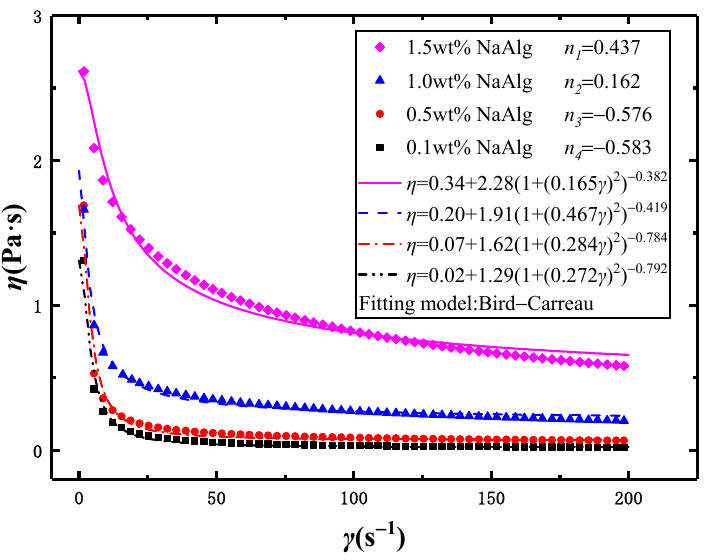
Figure 2. The relationship between the viscosity ( η ) and the shear rate ( γ ) with four mass fractions of the NaAlg solution (The solid line displays the fitting result of the Bird–Carreau model).